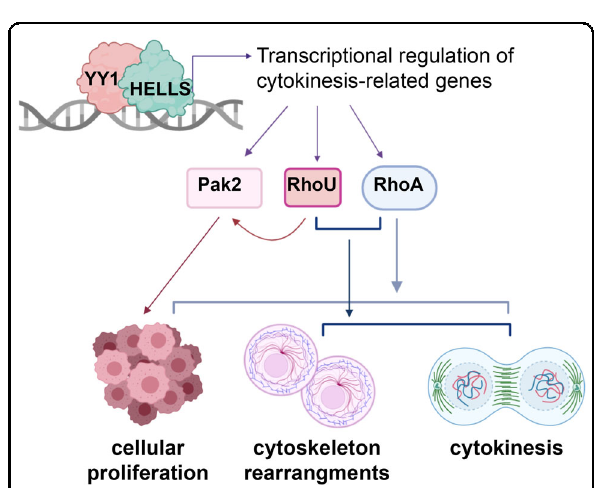
Fig. 6 Proposed molecular mechanism. Schematic representation of HELLS role in the regulation of ALK − ALCLs cytokinesis-related program (created with